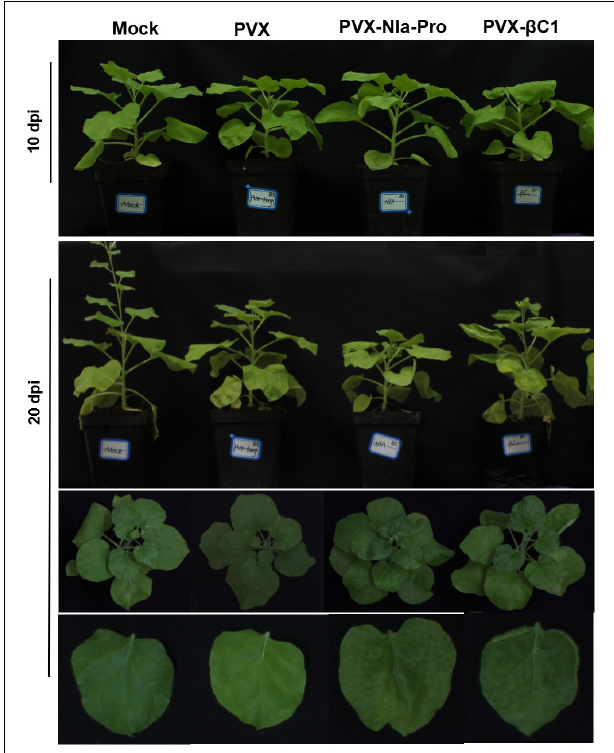
FIGURE 2 | Symptoms exhibited by plants following inoculation with